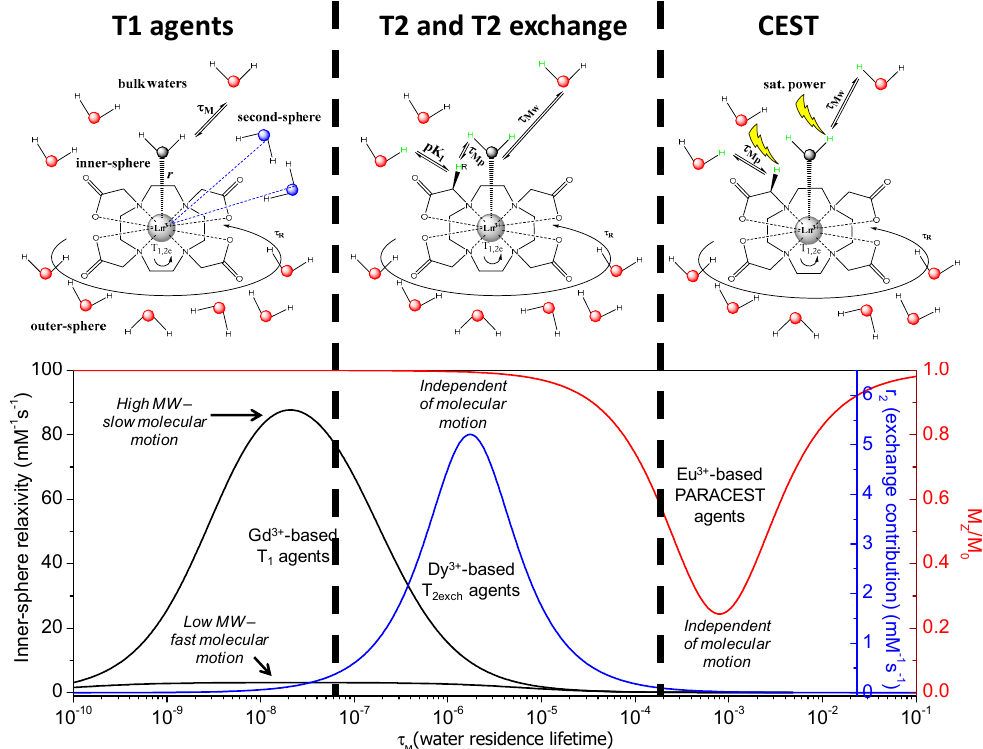
Figure 1. Schematic of T 1 , T 2 , T 2 -exchange, and chemical exchange saturation transfer (CEST) (paraCEST) lanthanide contrast agents (CAs) with one coordinated water molecule ( inner-sphere water, its oxygen is colored black) in solution ( bulk and outer-sphere waters, oxygens are in red). Second-sphere water molecules (water oxygens are colored blue). The parameters that govern the relaxivity are also represented: O–Ln distance ( r ), the mean lifetime ( τ M ) of the water molecules in the inner sphere, the rotational correlation time ( τ R ) and the electronic spin relaxation times ( T 1e and T 2e ) . Below, the corresponding simulated plots are represented, showing the contrast effect ( r 1 , r 2 , M z /M 0 ) vs. the τ M , assuming standard parameters from the literature.